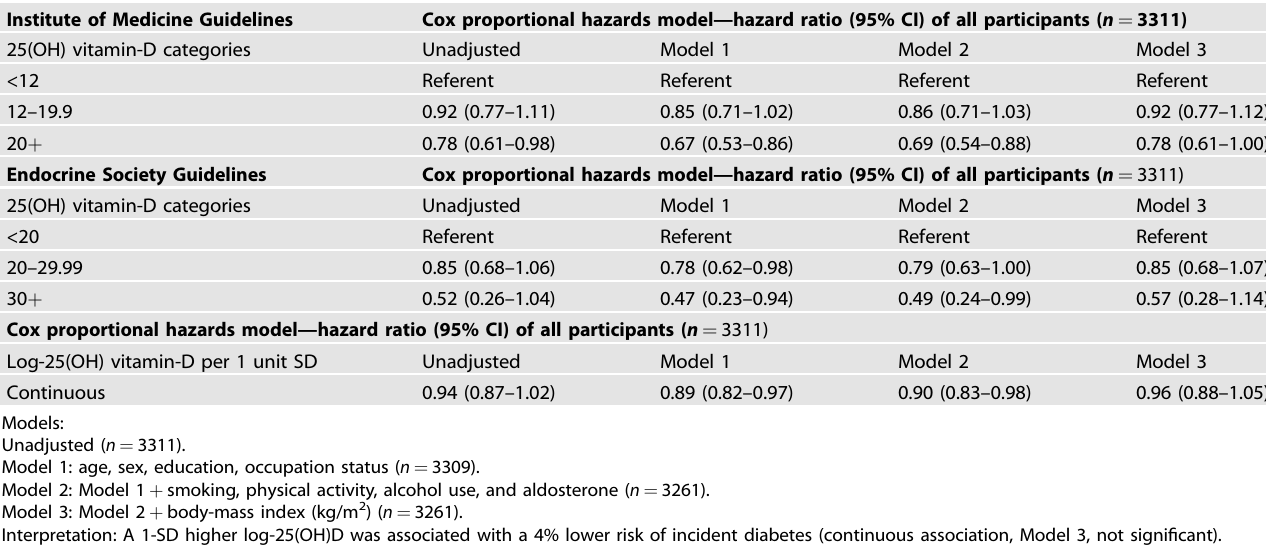
Table 2. The association of total 25(OH) vitamin D with incident